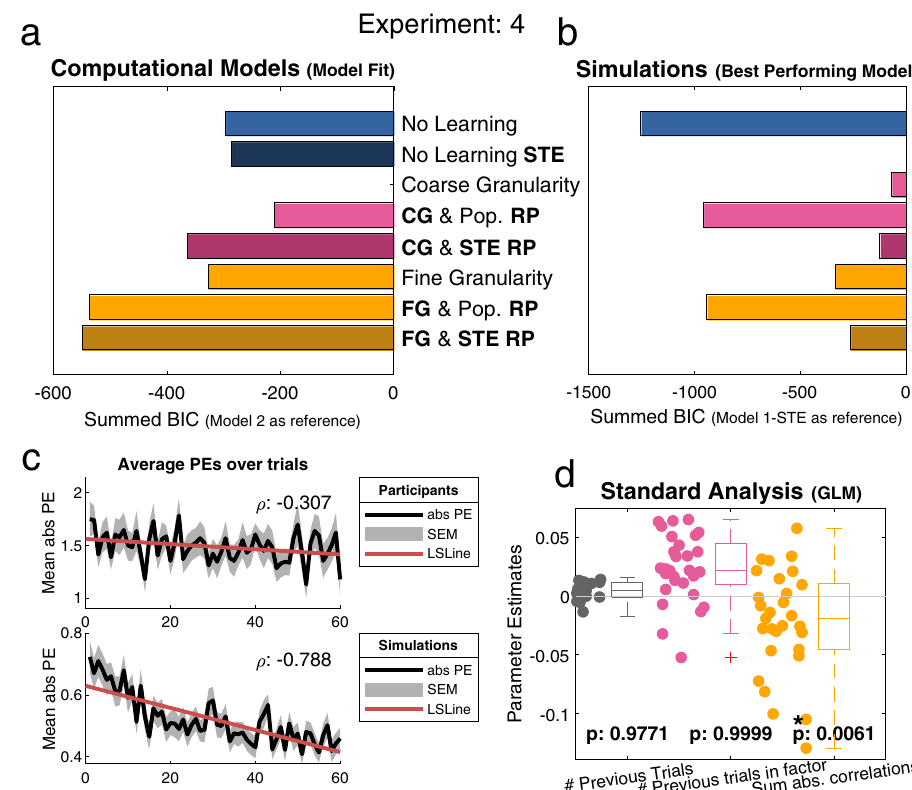
Fig. 6 | Overview of the main analyses for experiment 4. In this experiment participantslearnedaboutanout-group(i.e.,fashionmodels)insteadoftheregular in-group (i.e., students). Additionally, three models were added to our original set of fi ve models to capture stereotypic inclinations (STE). These stereotypic models have a darker colour in the fi gures and are indicated by STE in the model names. a As hypothesized, the best fi tting model was Model 5-STE [Fine Granularity & Stereotypic RP] ( n =29). This model uses the expected stereotypical self-ratings from models as a reference point and fi ne granularity for generalization. b Simulated data for the best performing model ( n =29). Contrary to participants ’ data the best performing model was model 1 [No Learning]. This indicates that participantsusedtoocomplexastrategyforlearningaboutthefashionmodels(see SupplementaryFig.8fordetails). c BothplotsdisplaytheaverageabsolutePEsover time±SEM.Top)Participants ’ datashowadecreaseinthePEsovertime( ρ : − 0.307, least squares line (red)), an indication of learning over time. Bottom) Simulated